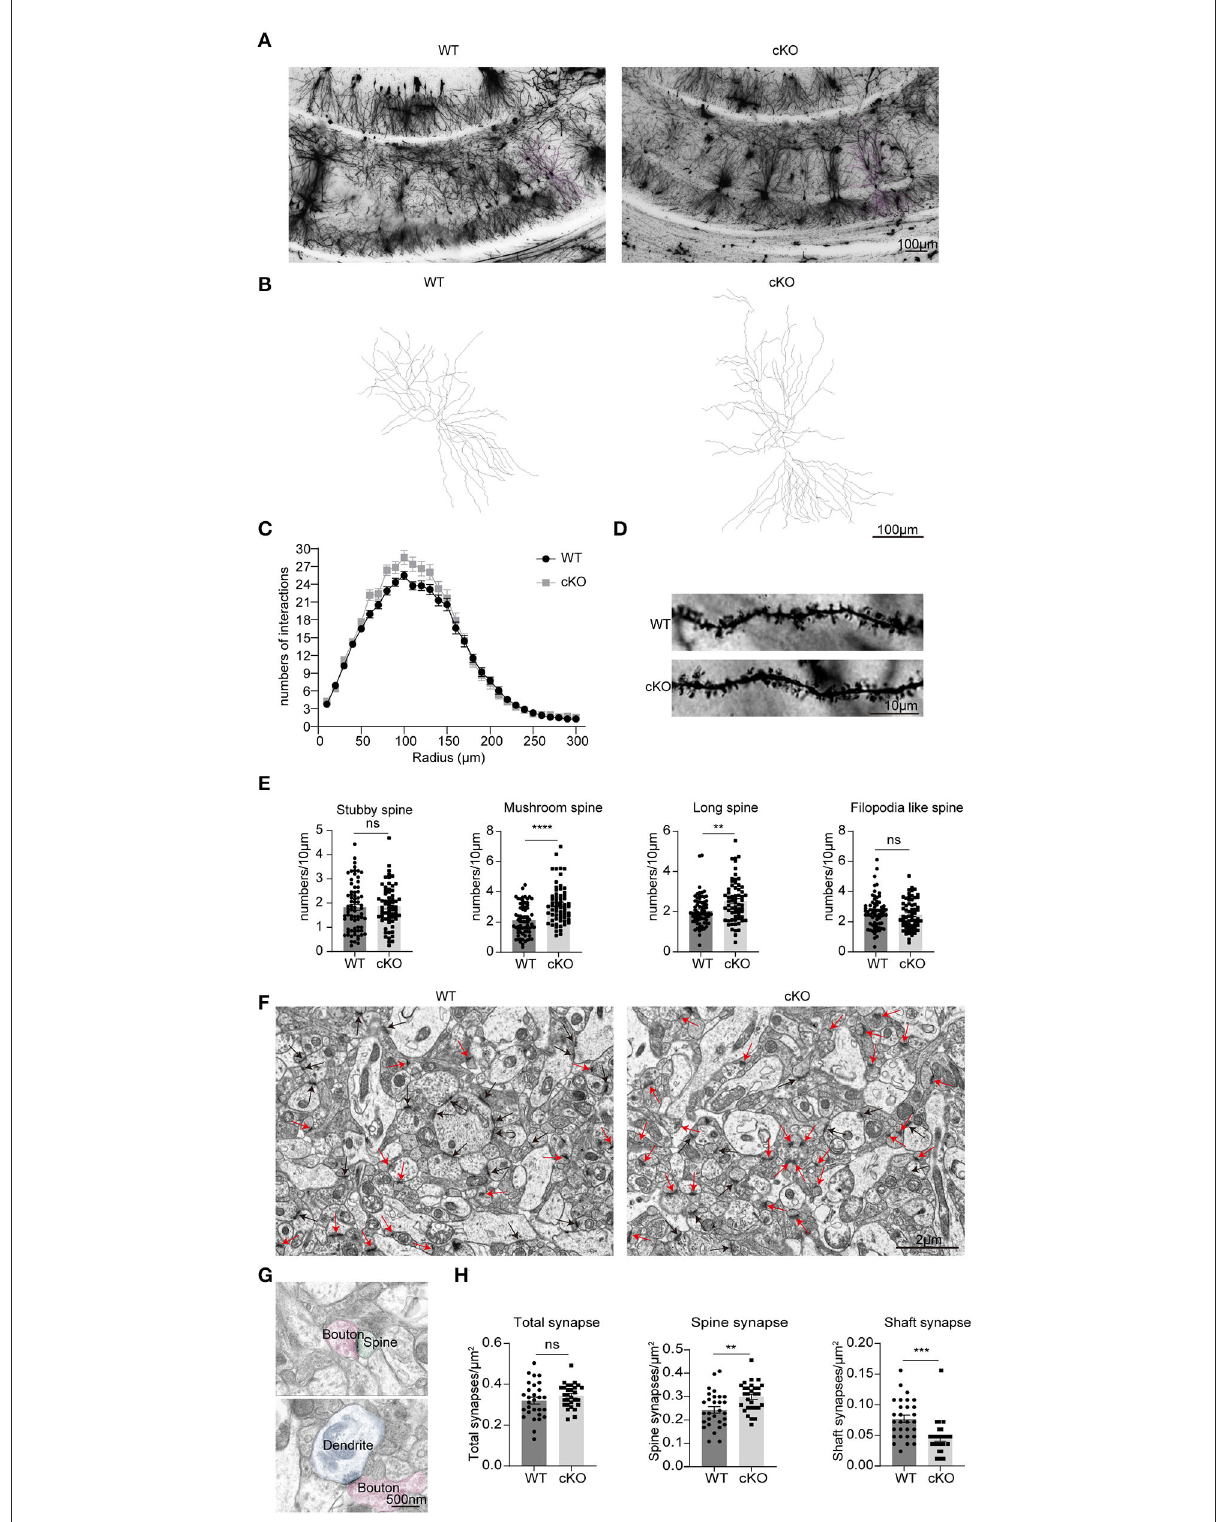
FIGURE7 Changes in neuronal complexity, dendritic spines, and synapses of the MAD2B cKO mice. (A) Representative images of neurons in the CA1 region; the scale bar is 100 µ m. (B) Representative traces of CA1 neurons; the scale bar is 100 µ m. (C) The number of intersections in the